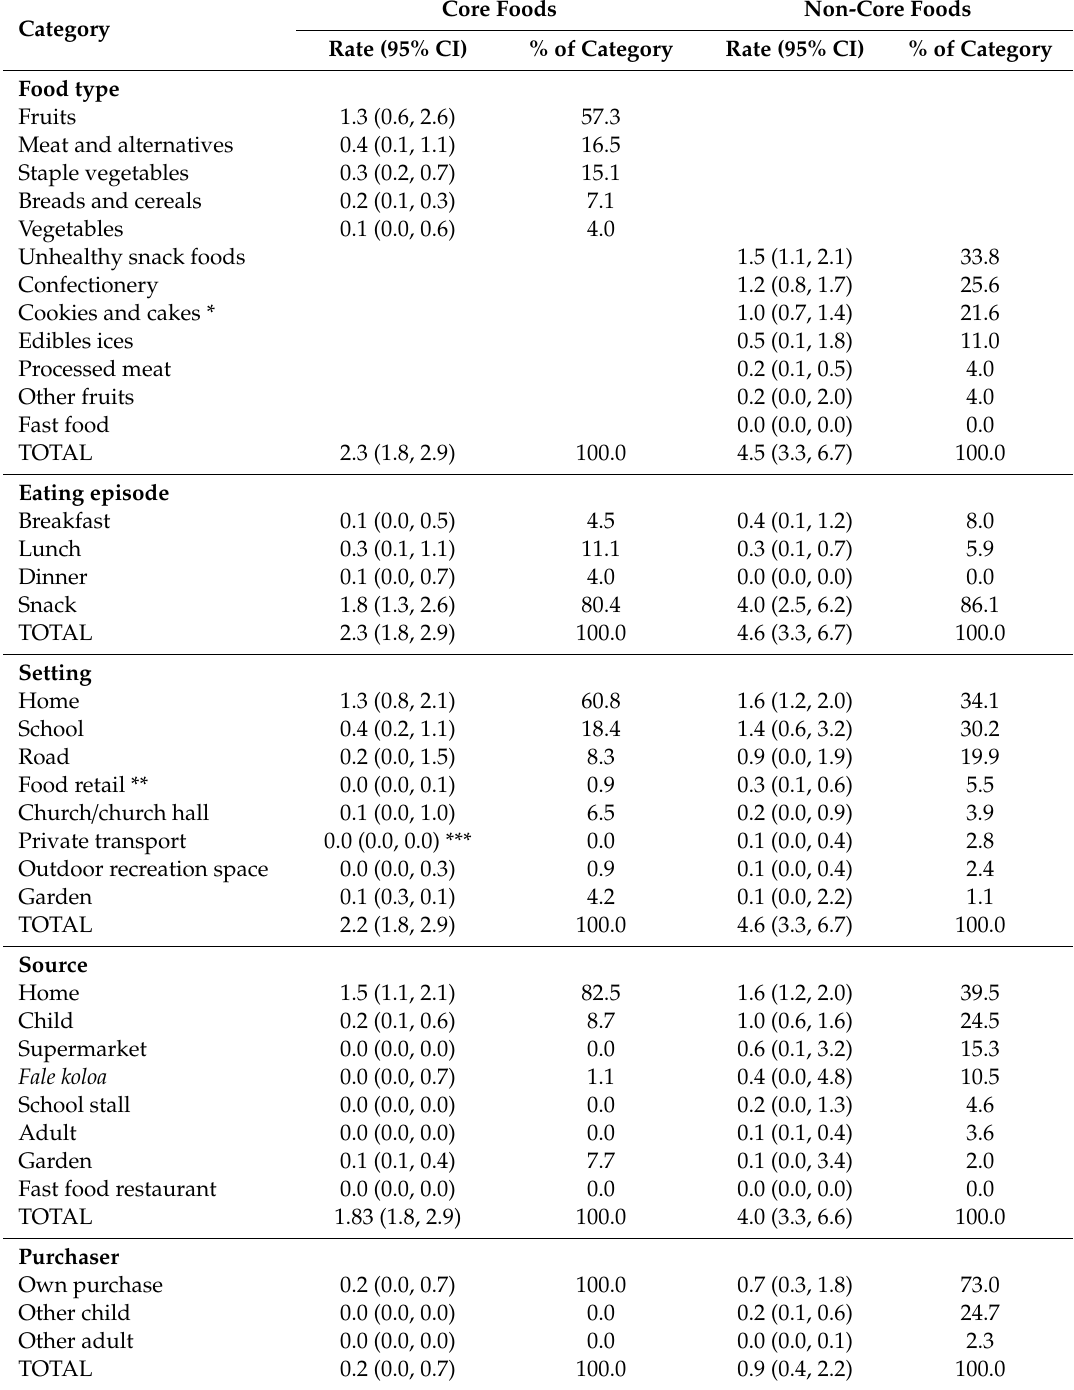
Table 3. Mean rates of core and non-core food consumption per 10 h day, and proportion of total category, by food type, eating episode, setting, source, and